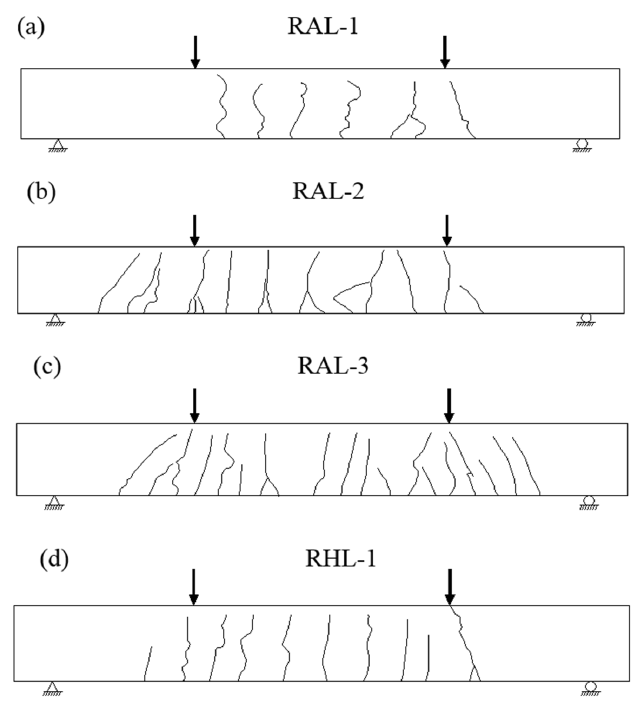
Figure 6. Crack shape and distribution of the test beam. ( a ) RAL-1, ( b ) RAL-2, ( c ) RAL-1, ( d ) RHL-